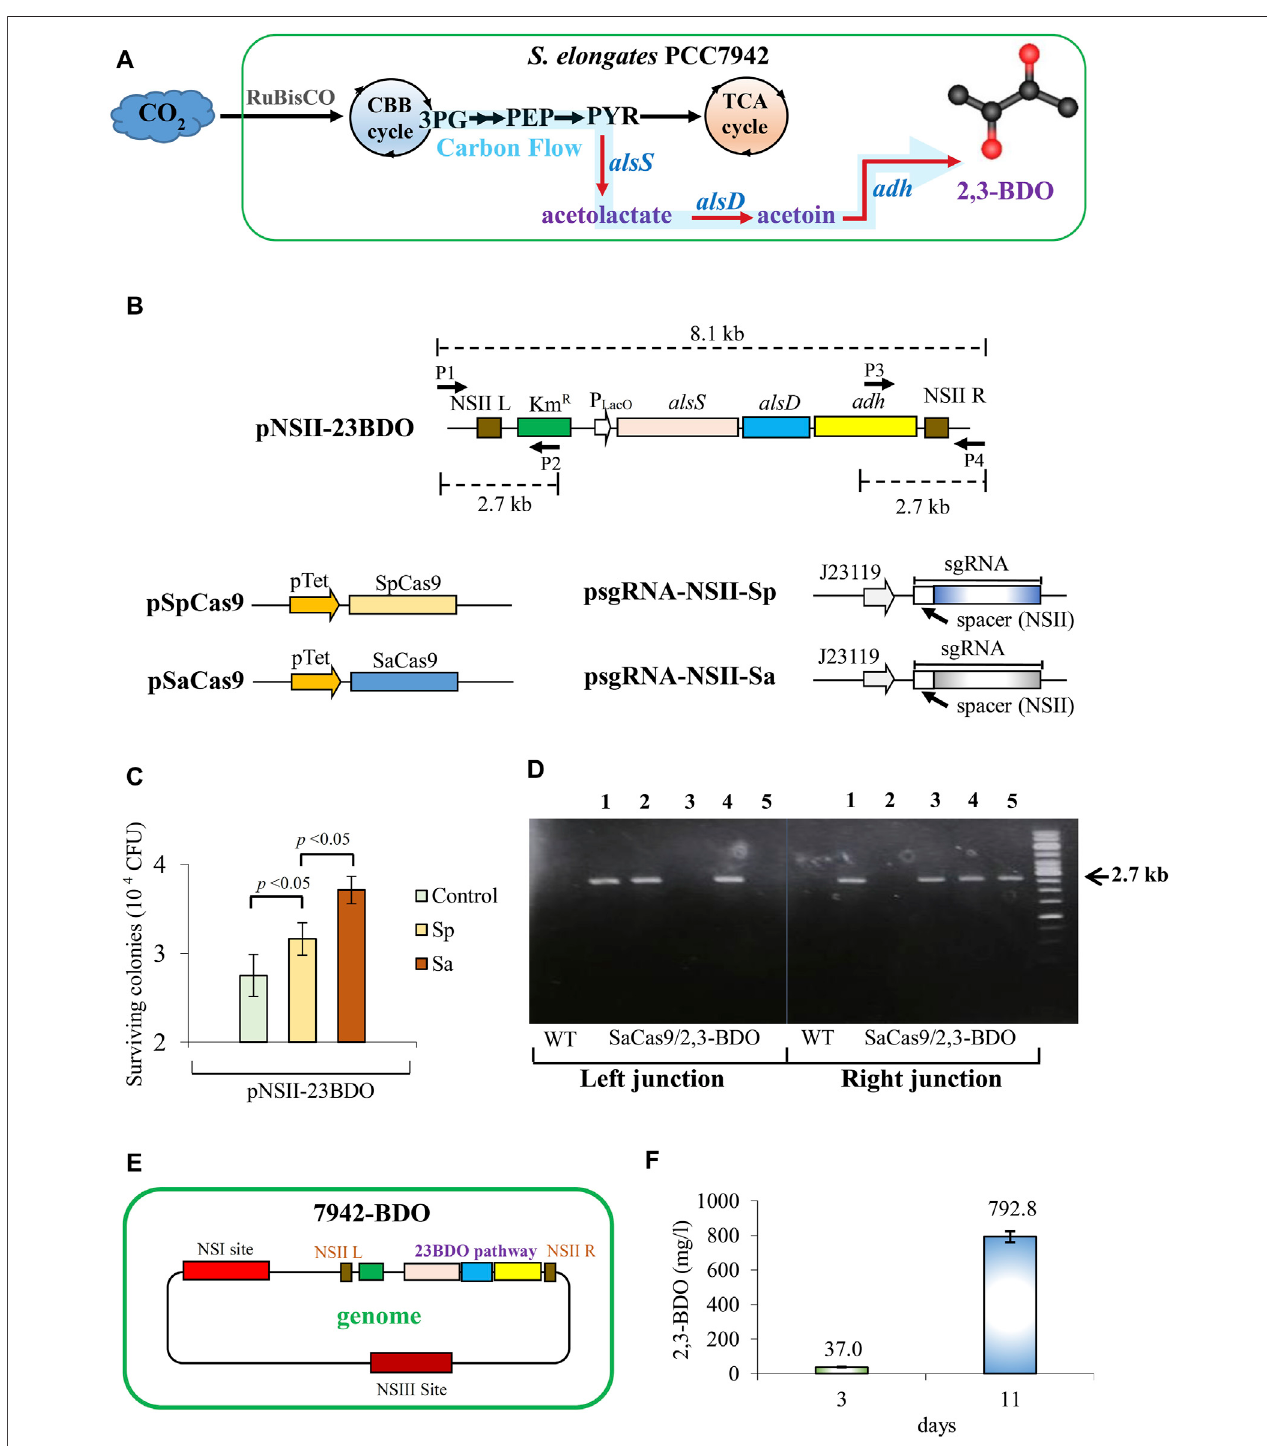
FIGURE 2 | Generation of 2,3-BDO-producing PCC7942 using SaCas9. (A) Pathway leading to 2,3-BDO production. CBB, Calvin – Benson – Bassham cycle; 3 PG, 3-phosphoglycerate; PEP, phosphoenolpyruvate; PYR, pyruvate. (B) Plasmids encoding 2,3-BDO pathway genes driven by repressor-less LacO promoter (pNSII-23BDO) and sgRNA plasmids correspondingtoSpCas9(psgRNA-NSII-Sp) and SaCas9 (psgRNA-NSII-Sa). sgRNA spacer wasdesigned totargettheNSII site. NRII L and NSII R are the homology arms for the NSII site. Km R , kanamycin resistance gene. P1 to P4 are primers used for PCR check. (C) CFU after co- transformation of 2000 ng pNSII-23BDO, 500 ng of pSpCas9/pSgRNA-NSII-Sp (Sp group), or pSaCas9/pSgRNA-NSII-Sa (Sa group) and Km selection. The control was transformed with only 2000 ng pNSII-23BDO. (D) PCR analysis of fi ve colonies from the Sa group using two primer pairs (P1/P2 and P3/P4) targeting the left and